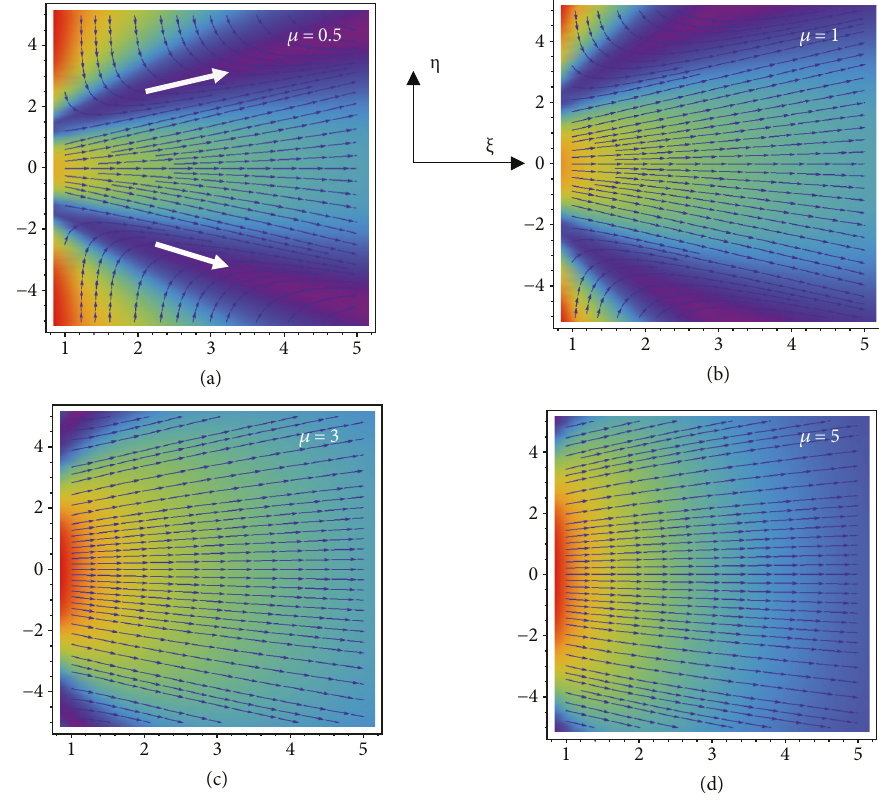
Figure 2: Flow velocity fi eld as given by (20) for various μ